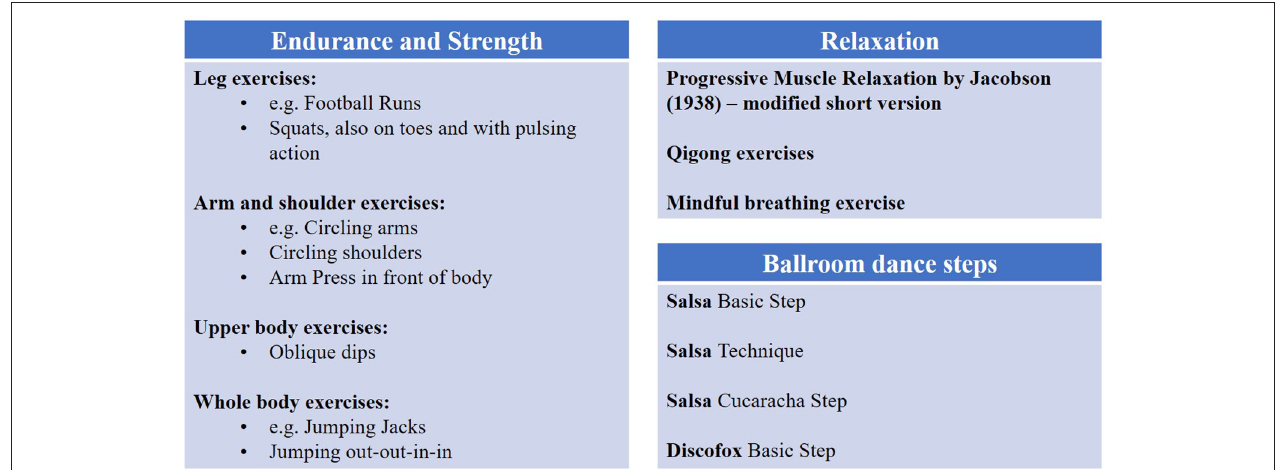
FIGURE 2 | Selection of exercises as part of the physical activity program. Muscular and endurance exercises were based on and adapted of the fitness program Blogilates by Cassey Ho (www.blogilates.com), inspired by high-intensity interval training with each exercise being carried out for 1–2 mins with short breaks of 10–15s in between. Relaxation sessions consisted of a modified version of Progressive Muscle Relaxation (PMR; Jacobson, 1938), qigong exercises and a mindful breathing exercise developed by Department of Applied Emotion and Motivation Psychology of Ulm University. Ballroom dance steps were taught by a certified dance teacher according to the guidelines by the Allgemeiner Deutscher Tanzlehrerverband e.V. (ADTV) . The steps were carried out without a partner. Progressive Muscle Relaxation-modified short version by Department of Applied Emotion and Motivation Psychology of Ulm University, originally by Jacobson